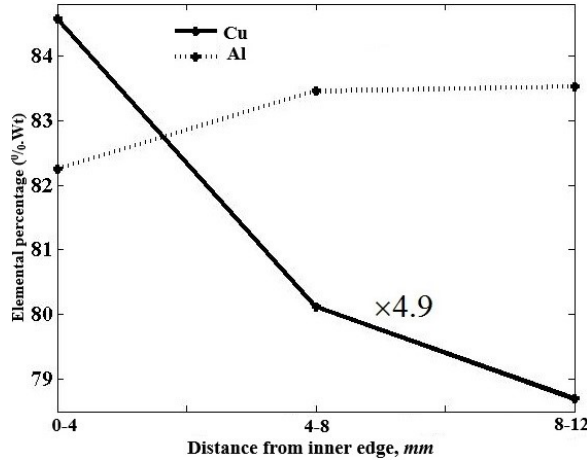
Figure 5: Distribution of Cu and Al along radial direction in the Al- Al 2 Cu FGM thick cylindrical shell measured by EDX analysis